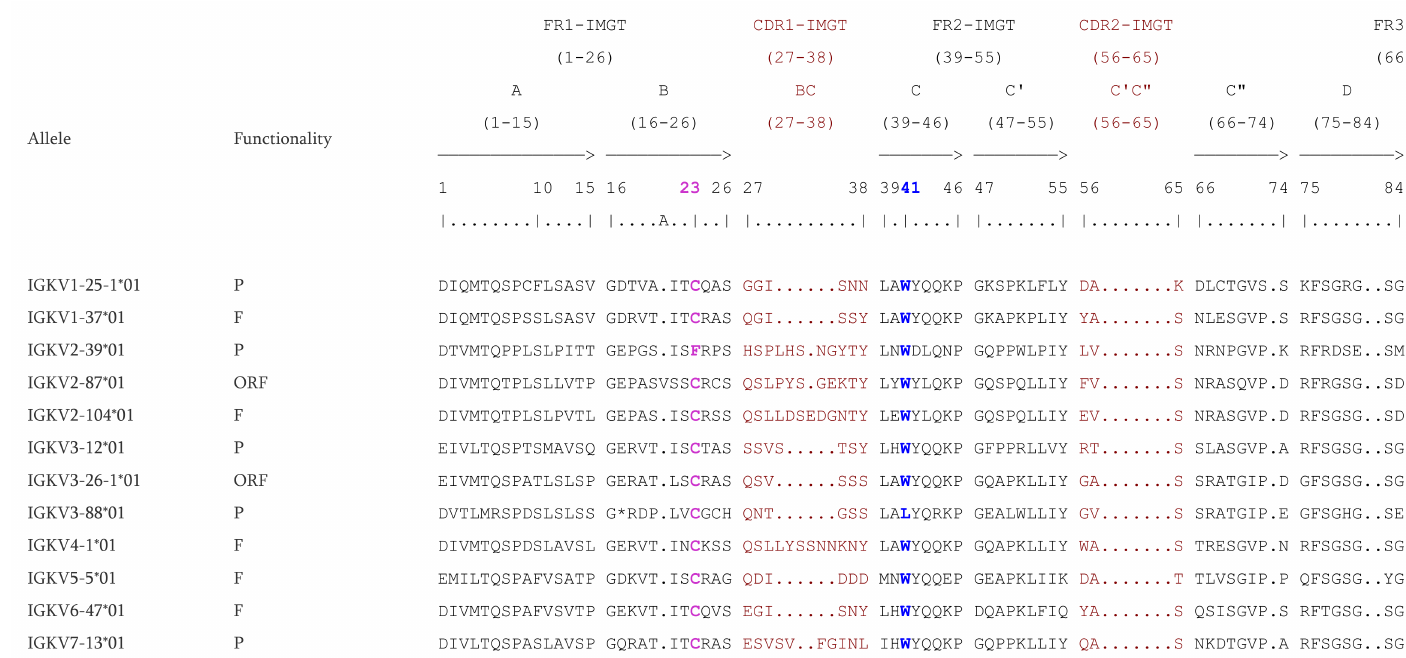
Figure 9. IMGT Protein display of the Rhesus monkey IGKV genes. Only a few functional genes, ORF and in-frame P are shown. The outline of complementarity determining regions (CDR-IMGT) and framework regions (FR-IMGT) are according to the IMGT unique numbering for V-REGION [70]. The four conserved amino acids are shaded in pink for the C23 and C104, blue for the W41 and hydrophobic AA 89. * indicates in frame STOP-CODON. The CDR-IMGT are shaded in maroon while the FR-IMGT are in black. Data available in IMGT Repertoire (IG and TR) http://www.imgt.org/IMGTrepertoire/, accessed on 11 November 2021 > Proteins and alleles > Protein displays > V-DOMAIN > IGKV > Rhesus monkey ( Macaca mulatta ) or IMGT DomainDisplay http://www.imgt.org/3Dstructure-DB/cgi/Do mainDisplay.cgi, accessed on 11 November